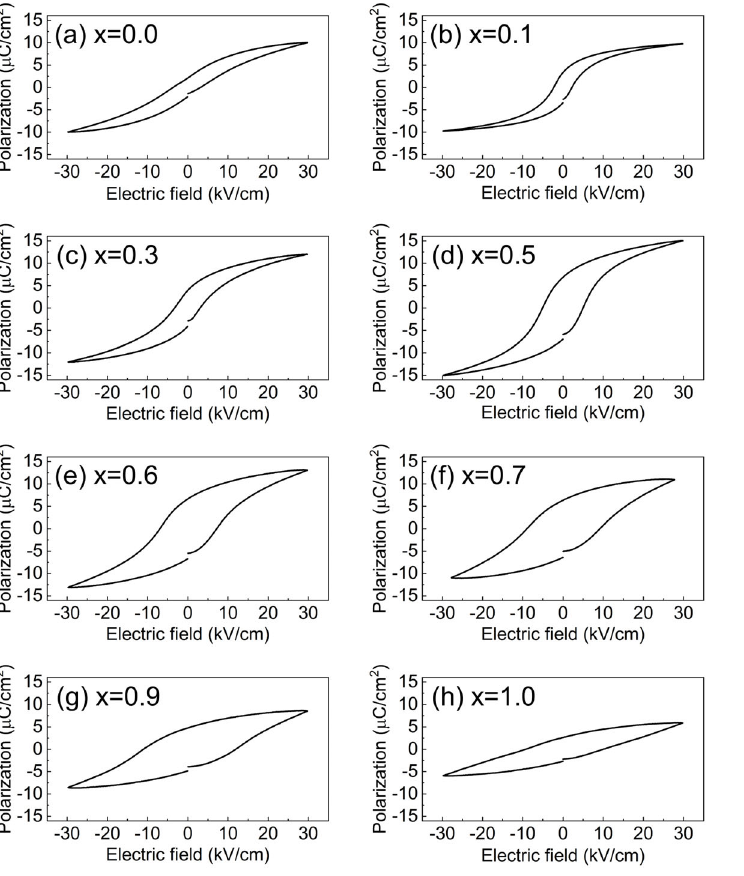
Figure 4. Polarization (P)—electric field (E) hysteresis loops for BZ 0.18 T–xBP 0.22 T: ( a ) 0, ( b ) 0.1, ( c ) 0.3, ( d ) 0.5, ( e ) 0.6, ( f ) 0.7, ( g ) 0.9, and ( h ) 1.0.